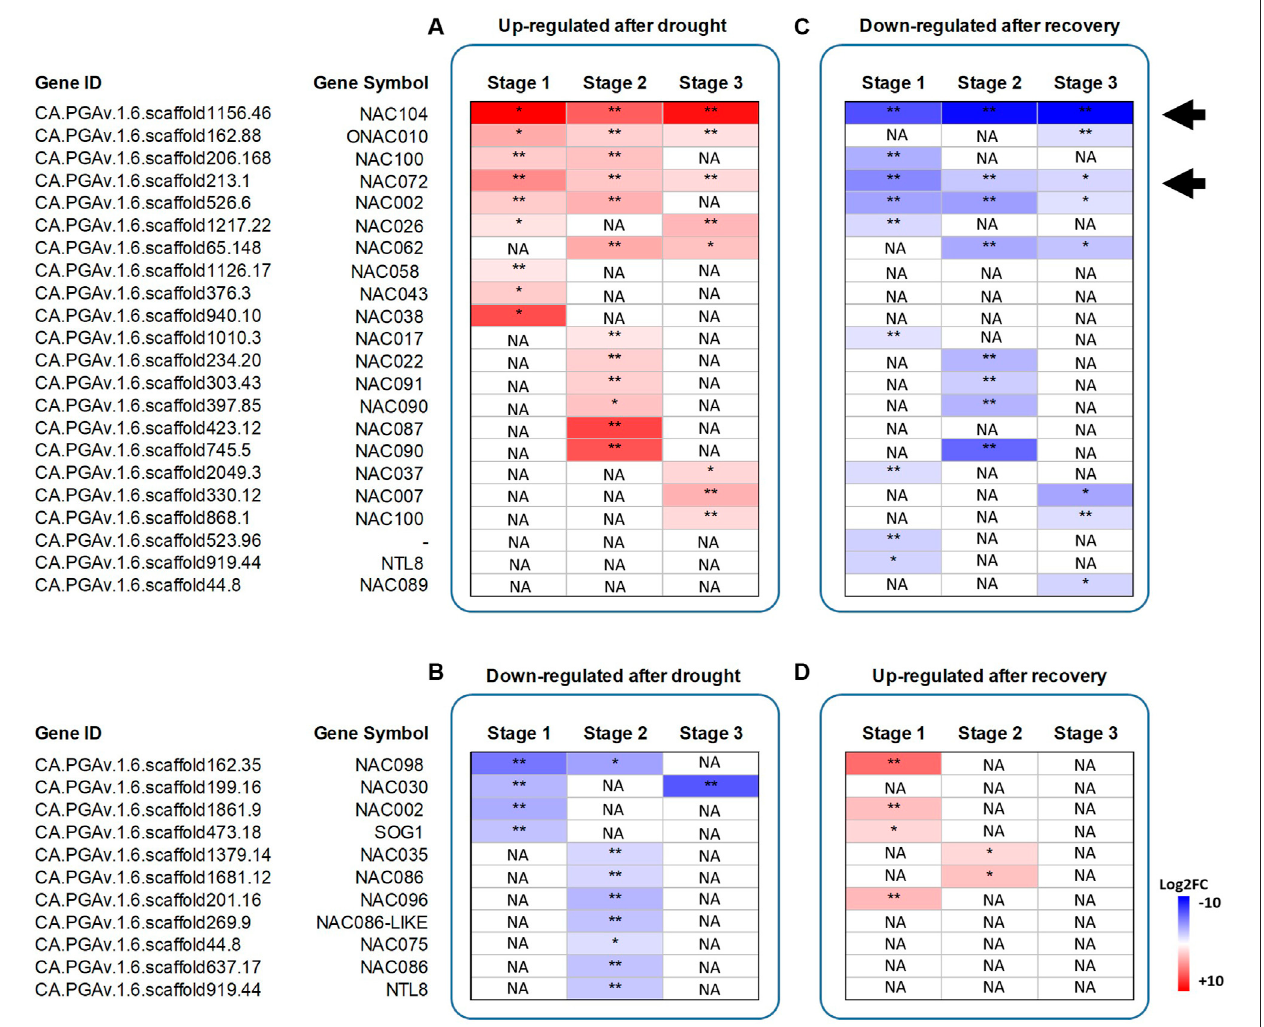
FIGURE 4 | Heatmap showing the log2 fold change differences in the expression of the differentially expressed NAC TFs identi fi ed. Genes upregulated after drought stress or recovery (Panel A and D ) and genes downregulated after drought stress or recovery (Panel B and C ). Black arrows highlight the two NACs selected for functional characterization, being always upregulated after drought, and downregulated after recovery. Data represent the means of three biological replicates. Asterisks represent statistically signi fi cant differences ( p values < 0.05*, Pvalues < 0.01**) between control and stressed plants, and between drought- stressedandrecoveredplants.The p valueswereadjustedusingtheBenjaminiandHochbergmethod.Corrected p valueof0.005and|log2(FoldChange)|of1wereset as the threshold for signi fi cantly different expression. White fi elds indicate the absence of signi fi cant differences between treatments. NA stands for “ Not applicable ” .